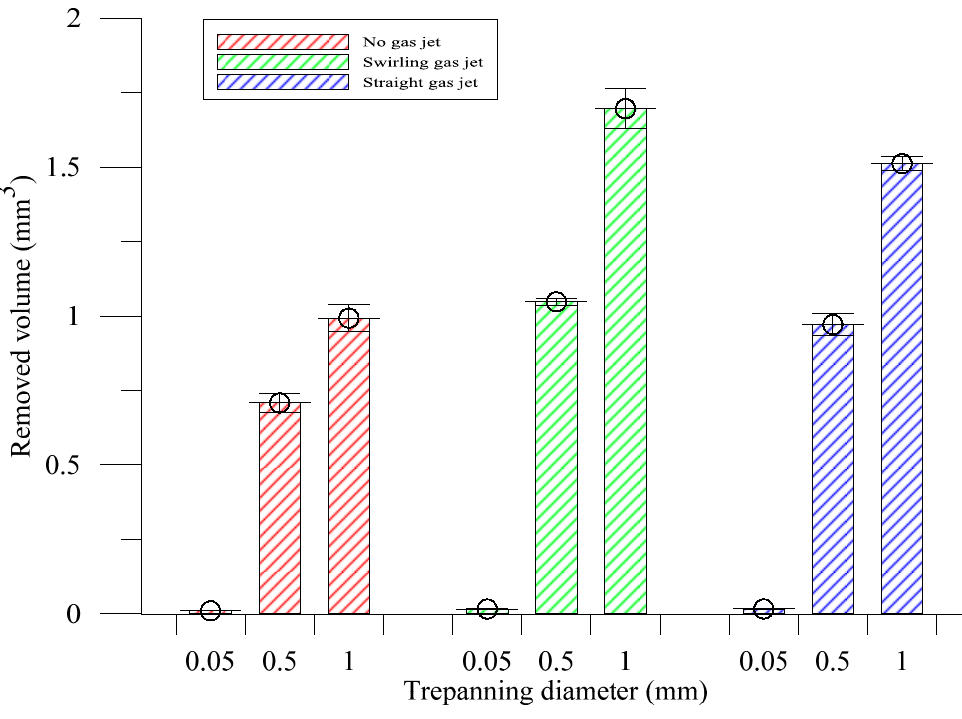
Figure 13. Laser trepanning depth with different gas jet configurations (no gas jet, swirling gas jet, and straight gas het) at different trepanning diameters. Appl. Sci. 2017 , 7 , 502